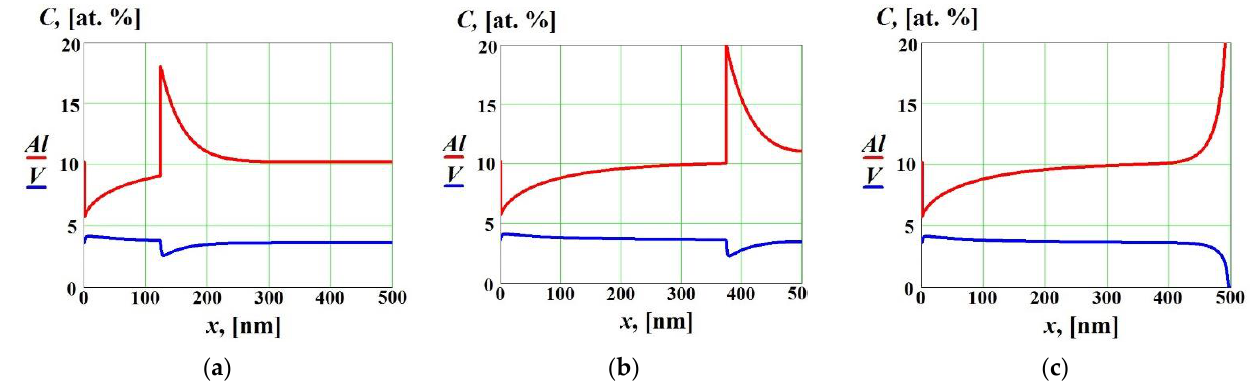
Figure 6. Solute concentrations in the liquid and solid phases as functions of the coordinate x at V < V D and V > V D with strong negative cross diffusion effects ( D 12 = 0, D 21 = − 1.5 · 10 − 8 m 2 /s) at different time moments: ( a ) t = 54 ns; ( b ) t = 163 ns; ( c ) t = 217 ns (complete